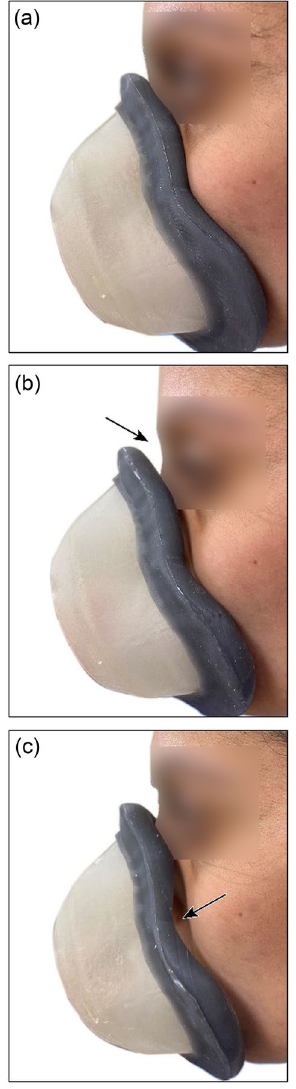
Figure 7. Figure showing ( a ) best matching eye-to-chin and nasal profiles ( b ) a nasal profile mismatch leading to lifting of the device away from the nose and loss of seal and ( c ) a combination of eye-to-chin and nasal